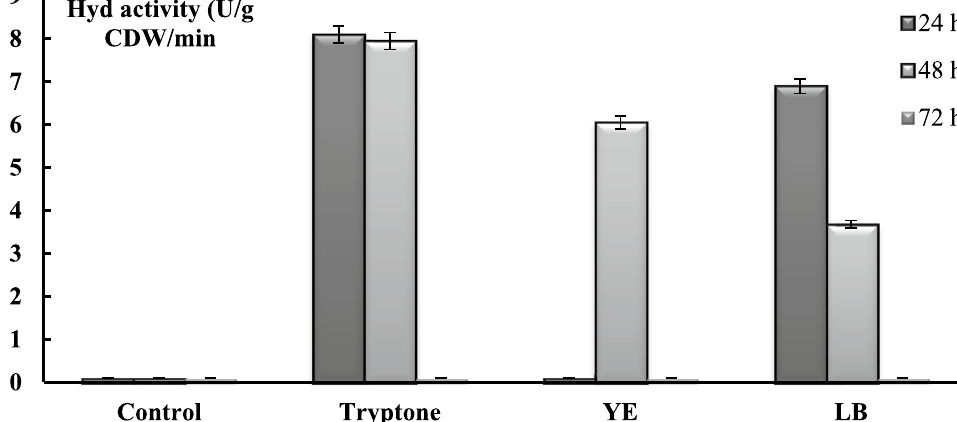
Fig. 2 LB medium components influence H 2 -oxidizing total Hyd activity of R. eutropha H16 whole cells. CDW is Cell Dry Weight. One unit of Hyd activity was defined as the amount of enzyme which that catalyzes the conversion of 1 mmol of H 2 per min. For the other details, see Materials and methods and the legends in Fig. 1, (n 5, p < =